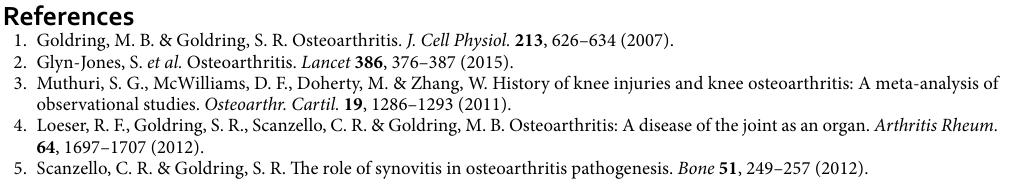
Figure 5. Characterization of cells invading damaged menisci. All cells infiltrating into the meniscus of DMM animals were vimentin positive. IHC with CD45 (leukocyte marker), F4/80 (macrophage marker) or collagen type X (marker for chondrocytes) showed only few positive cells (black arrows) mainly outside of the meniscus indicating most of the cells infiltrating the meniscus are fibroblasts. These results were comparable in DMM or sham surgery (4 weeks: ND h (healthy) n = 3, ND DMM n = 10, HFD h n = 3, HFD DMM n = 10; 6 weeks: ND h n = 3, ND DMM n = 10, HFD h n = 3, HFD DMM n = 7; 8 weeks: ND h n = 4, ND DMM n = 10, HFD h n = 4, HFD DMM n =